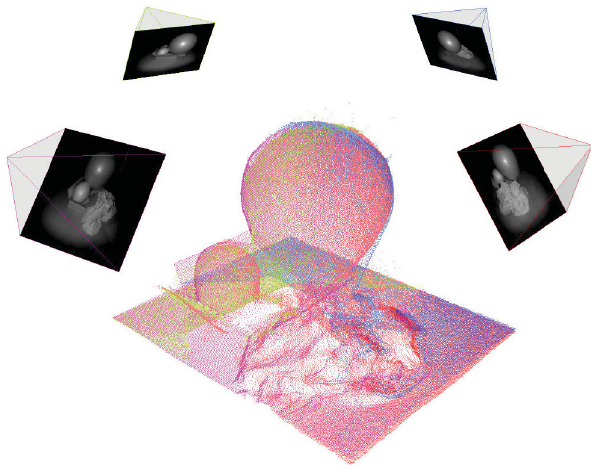
Fig. 2 Example camera setup. Four RGB-D cameras, shown with infrared images, capture a point cloud of a sample scene. The colors of the points indicate capture by different